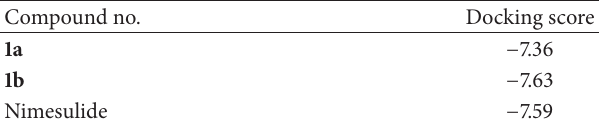
Table 4: Compounds docking scores compared with indomethacin. Compound